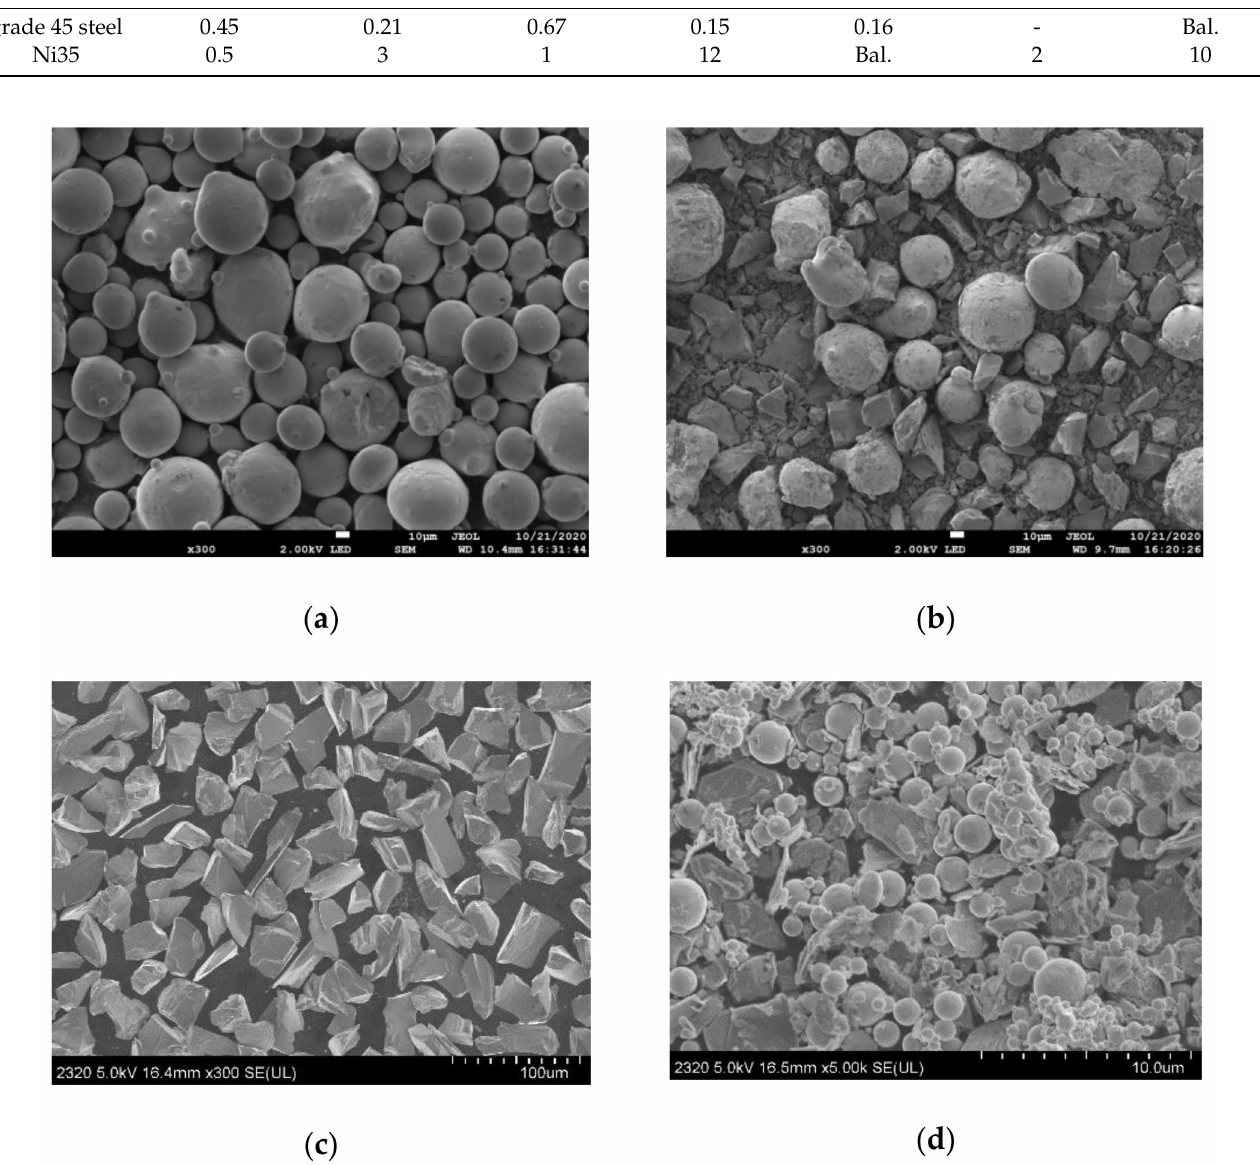
Figure 1. Micromorphology of the powder. ( a ) Ni35; ( b ) Ni35 + 20% SiC; ( c ) SiC; ( d ) Ni/MoS 2